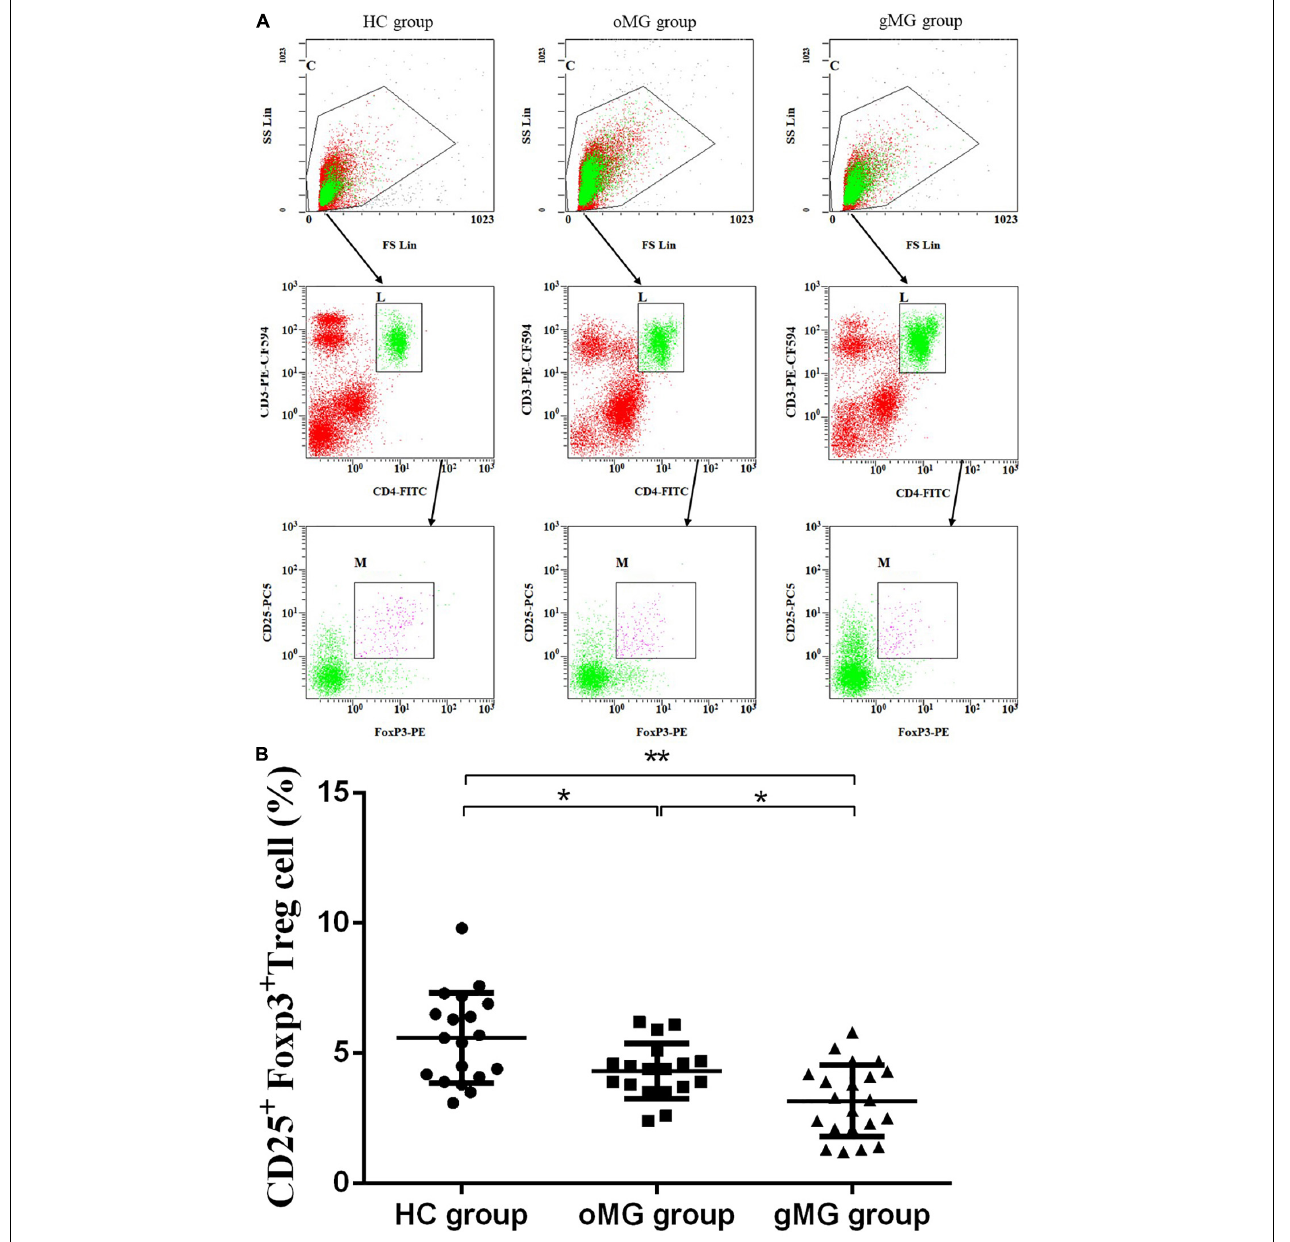
FIGURE 2 | Different expression of CD3 + CD4 + CD25 + Foxp3 + Treg cells in peripheral blood of MG patients (oMG: n = 18, gMG: n = 21) and HCs ( n = 19). (A) Representative flow cytometry plots of CD3 + CD4 + CD25 + Foxp3 + Treg cells in MG patients and HCs. (B) Comparison of the frequency of CD3 + CD4 + CD25 + Foxp3 + Treg cells between MG patients and HCs. The results are expressed as the Mean ± SD of three independent experiments (* p < 0.05, ** p <